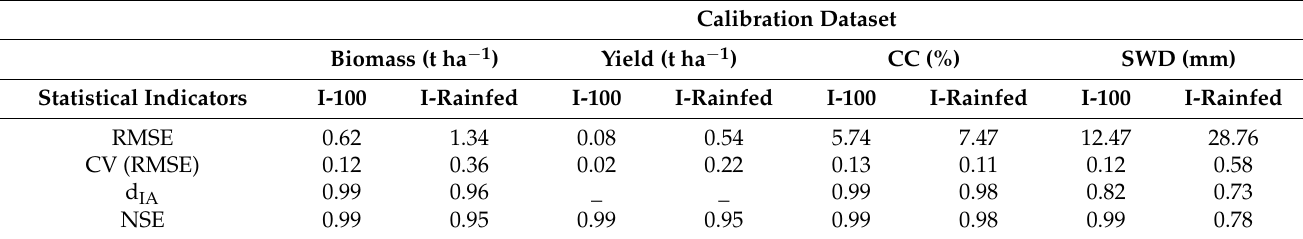
Table 5. Statistical indices derived for evaluating the performance of AquaCrop model in simulating biomass, yield, canopy cover, and soil water depletion for winter wheat (calibration